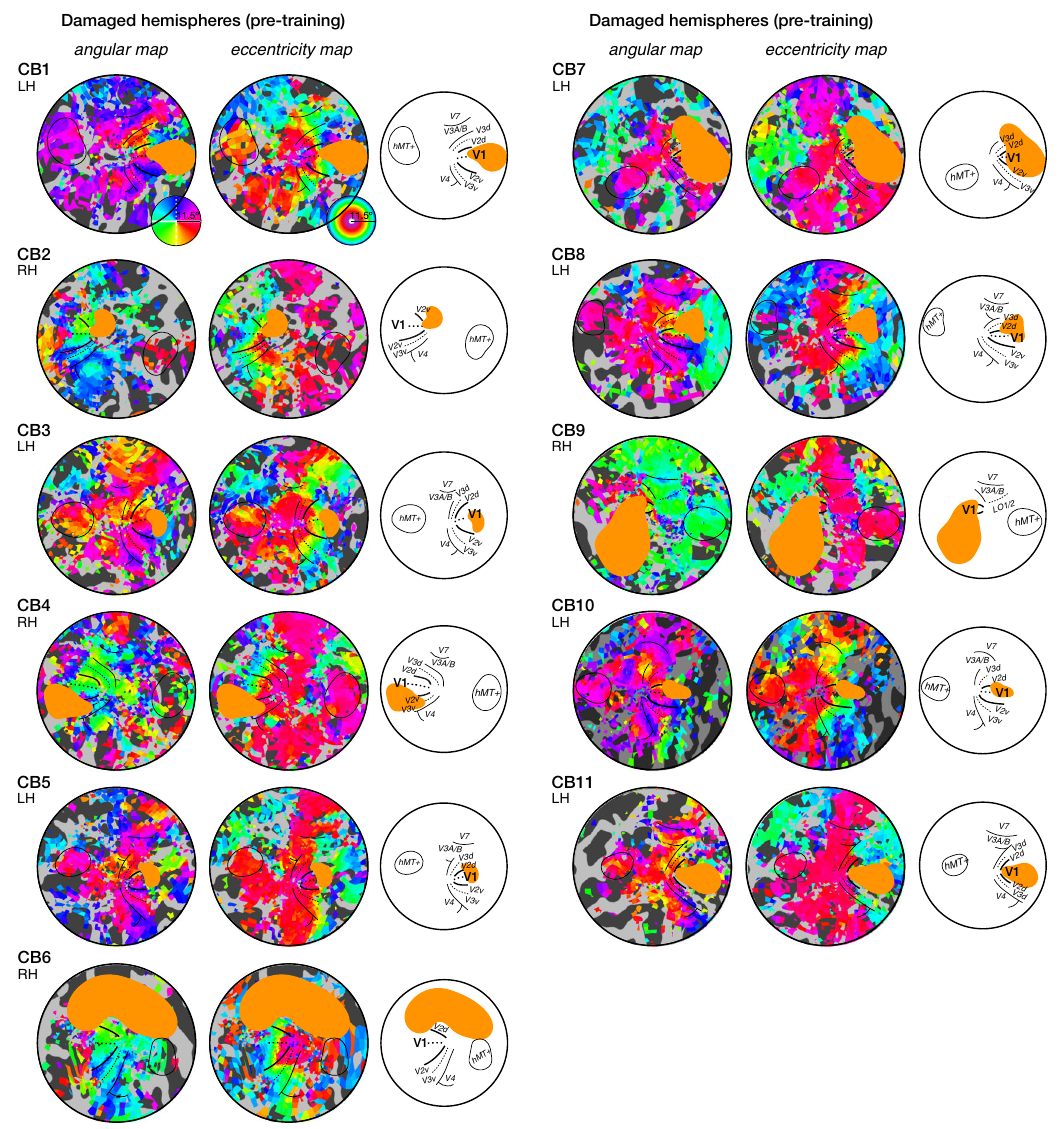
Fig. 3 Pre-training retinotopic maps of the damaged hemispheres of all 11 chronic CB patients. All patients retained retinotopic organization, both in terms of radial and eccentric representations. Stroke-induced lesions (orange masks) overlapped with V1 in most cases, as well as with other extrastriate